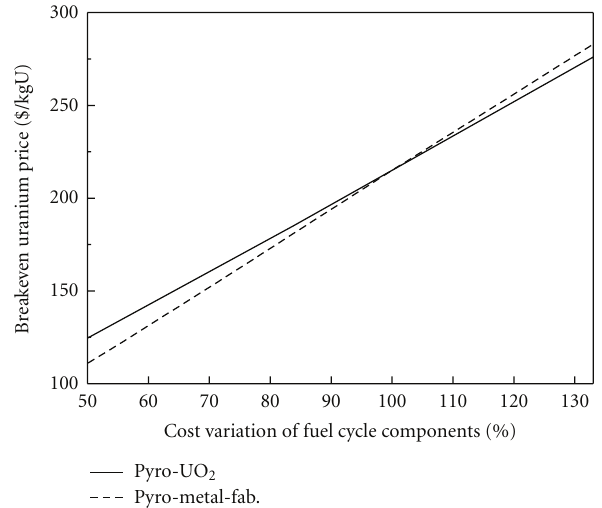
Figure 8: Break-even uranium price dependent on pyrotechniques.